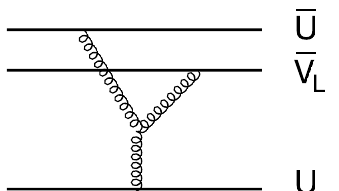
Figure 7. An (cid:11) s suppressed correction to a correlator containing (cid:22) V L which is negligible in the weak coupling